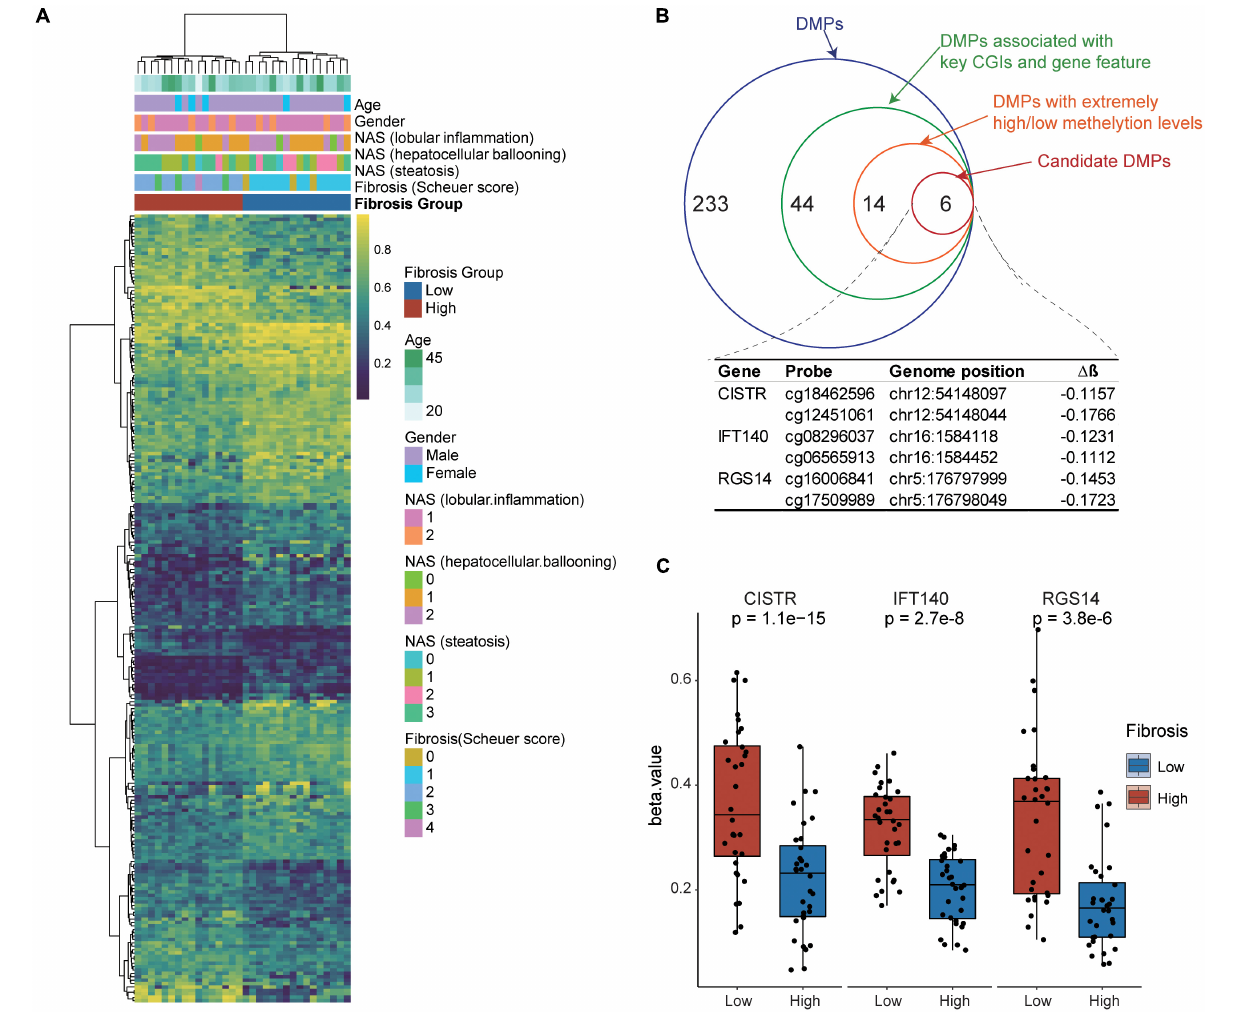
FIGURE 4 | Identification of candidate biomarkers from blood differentially methylated genes for liver fibrosis. (A) Association of DNA methylation and clinical features with liver fibrosis. The unsupervised hierarchical cluster analysis of DMPs was performed. DMPs in CpG islands are presented in the rows and independent samples are presented in the columns. The colors in the cells represent methylation level. Blue, unmethylated; red, fully methylated. (B) Step-wise selection of candidate DMPs for liver fibrosis. Three genes, i.e., CISTR , IFT140 , and RGS14 , each harboring at least two DMPs were finally selected. (C) The methylation levels in the CpG island regions of blood CISTR , IFT140 , and RGS14 genes in the NSLF group were significantly higher than those in the SLF